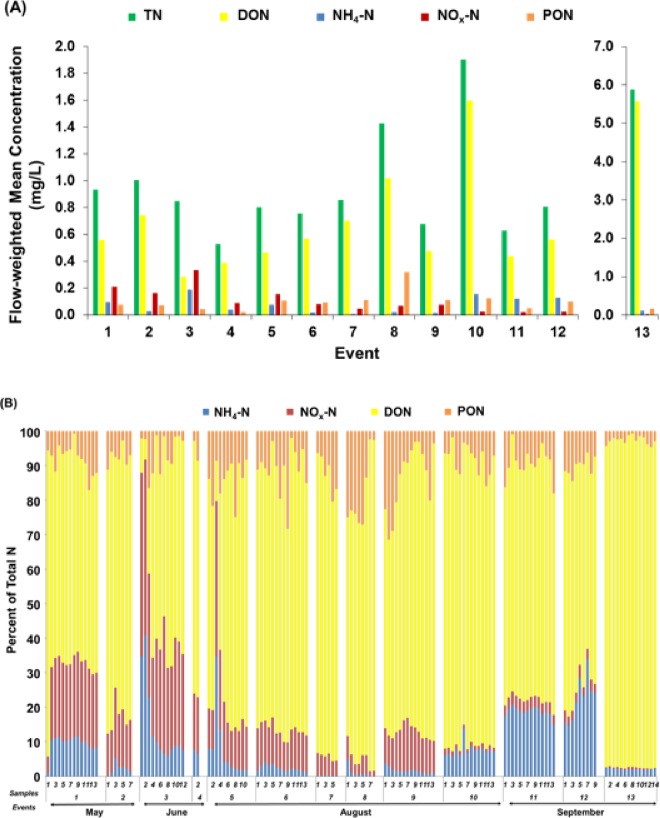
(A) Flow-weighted mean concentration (FWMC), and (B) composition of nitrogen forms in individual pond outflow samples from May to September 2016 (n = 13 storms; n = 144 samples).